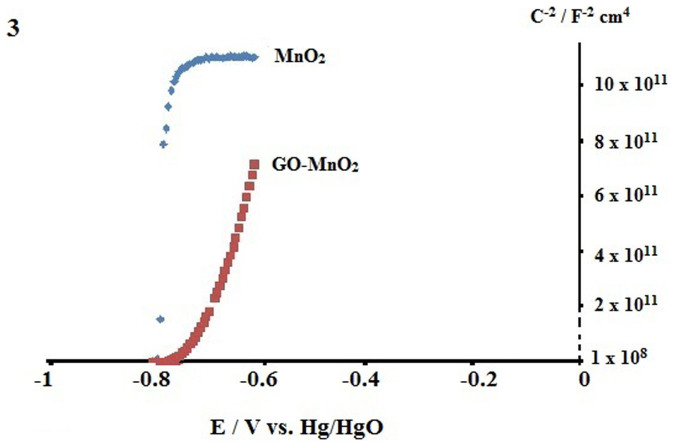
Mott-Schotkky plots of MnO2 and GO-MnO2.